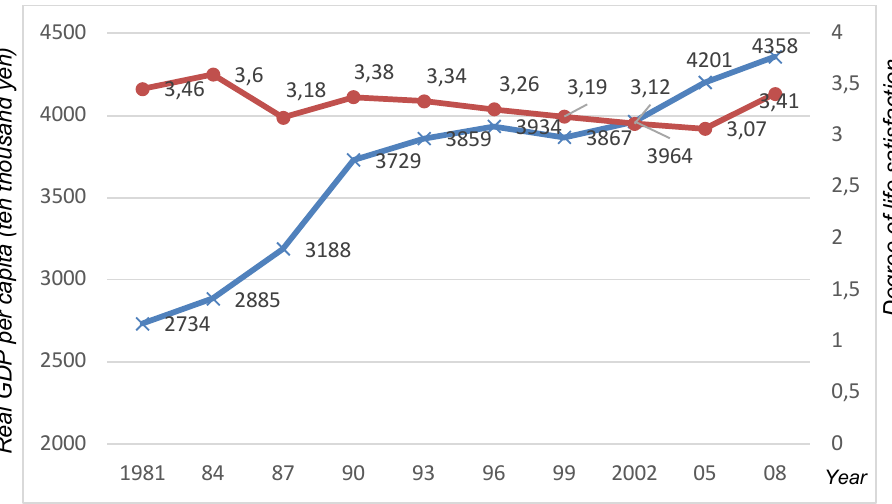
Figure 1. Japanese real GDP per capita and the Degree of Life